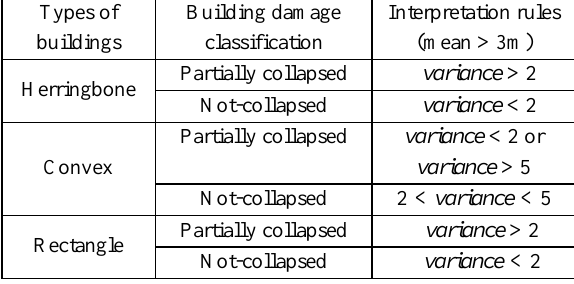
Table 1. Interpretation rule for partially collapsed buildings in different types of